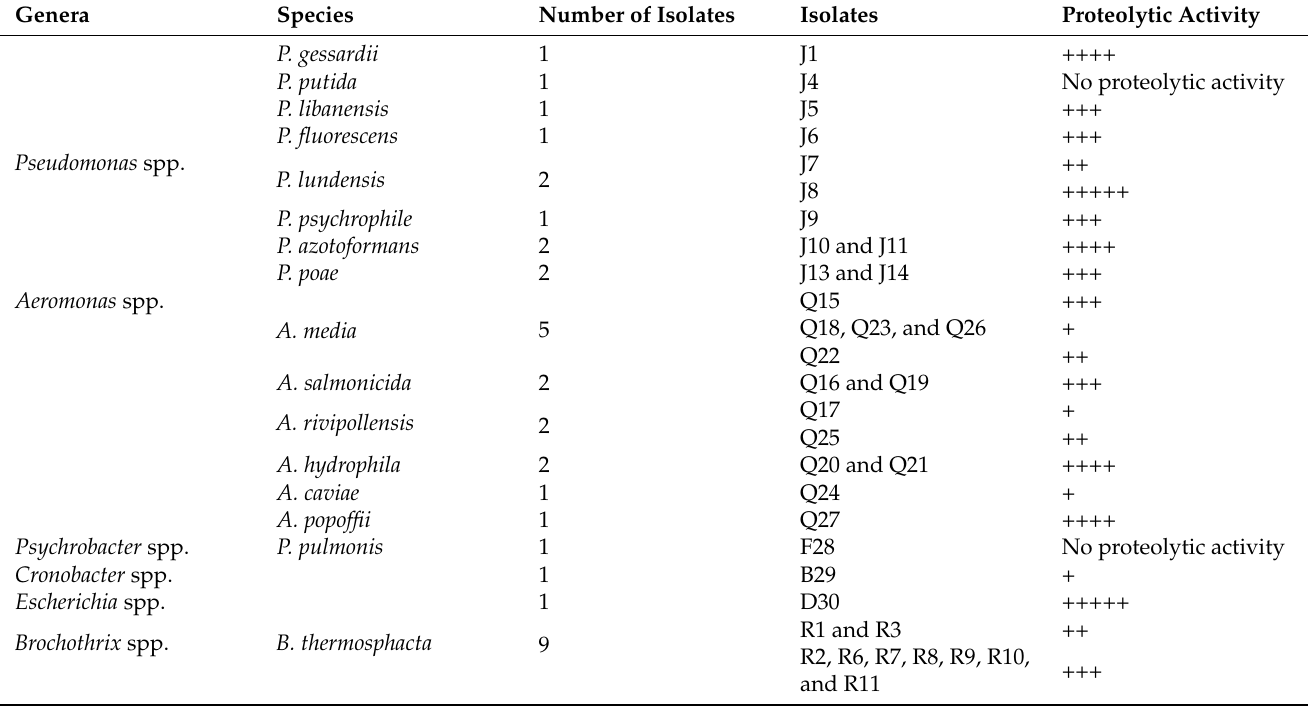
Table 1. Skim milk agar assay of the bacterial isolates.